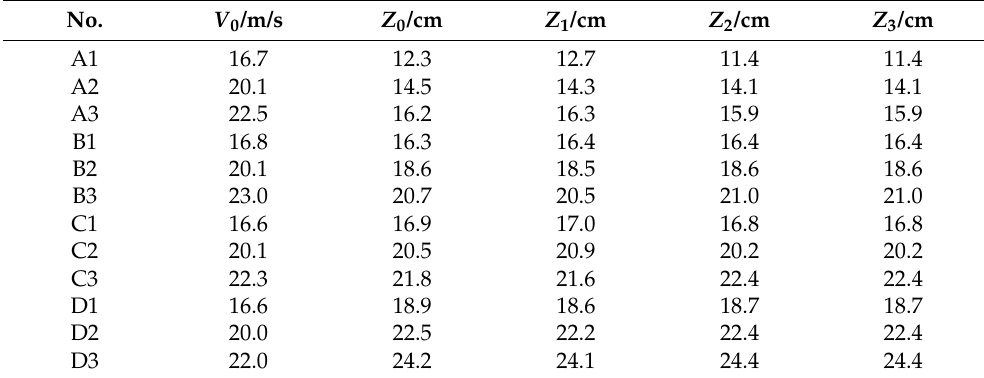
Table 3. Comparison of final penetration